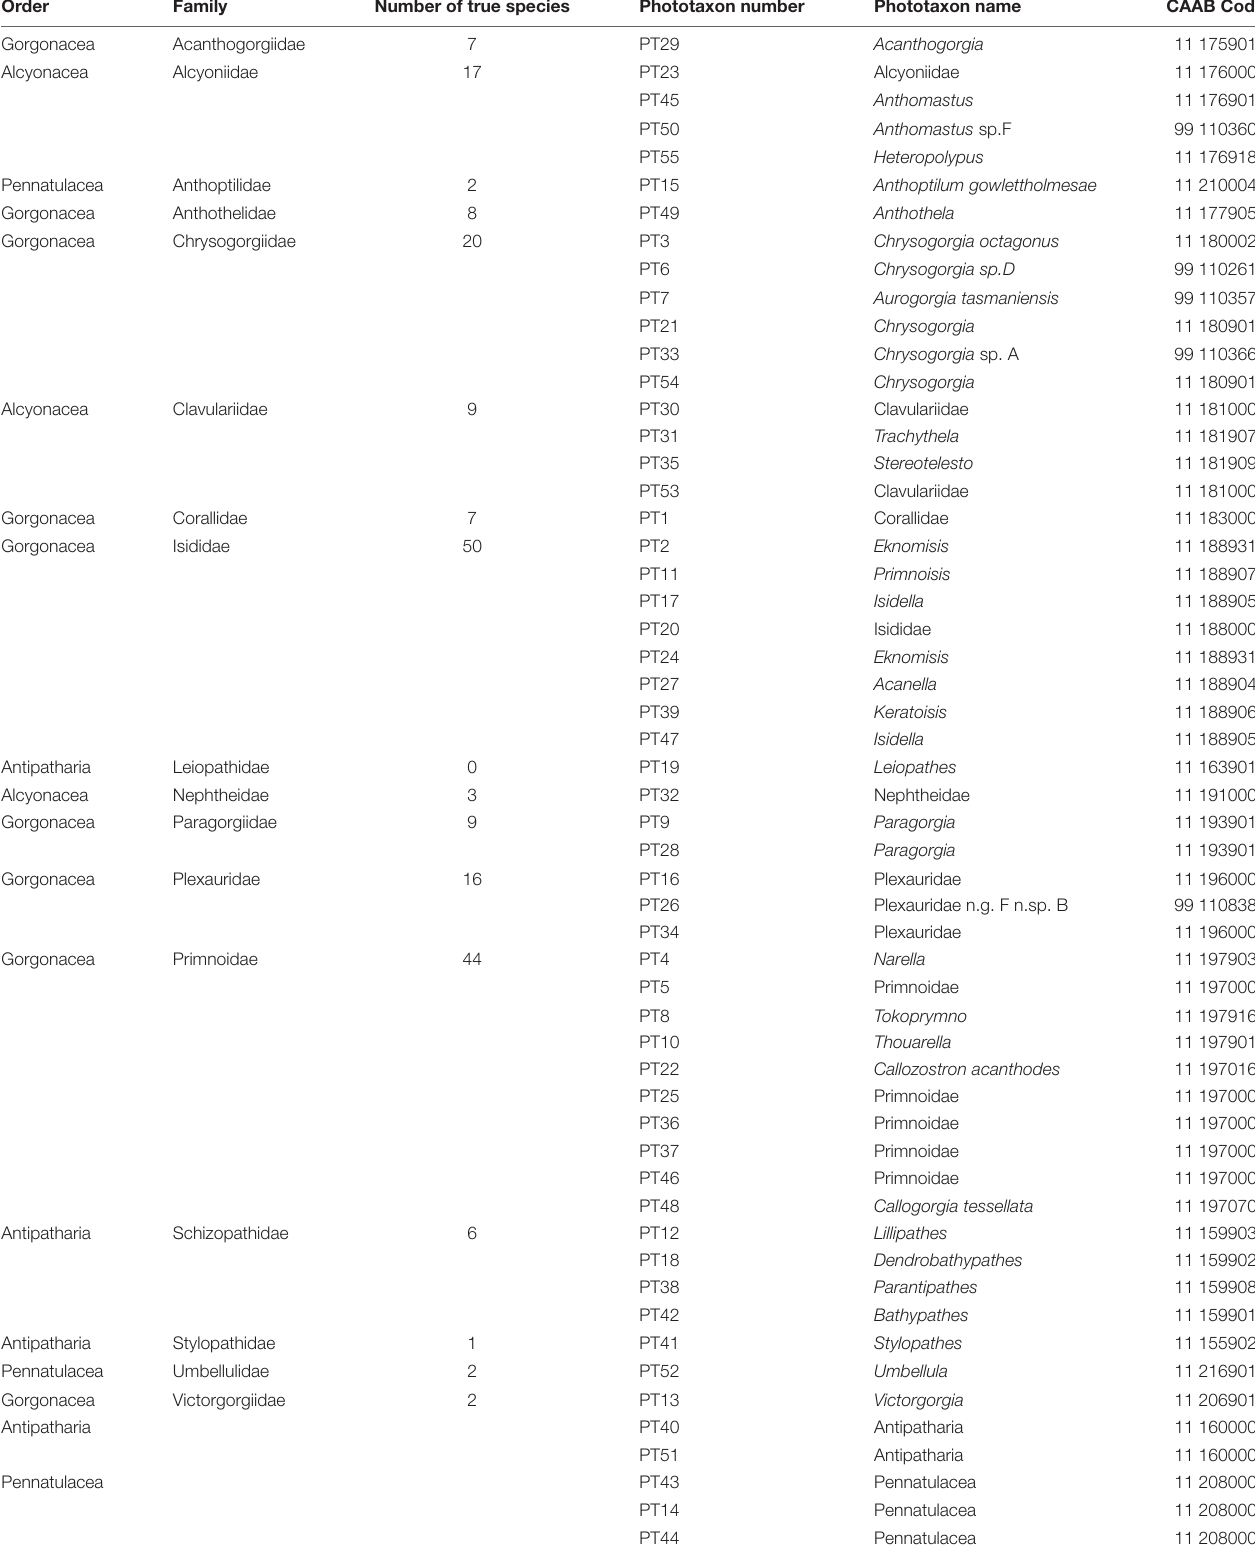
TABLE 3 | Details of black and octocoral phototaxa (PT) scored from imagery.